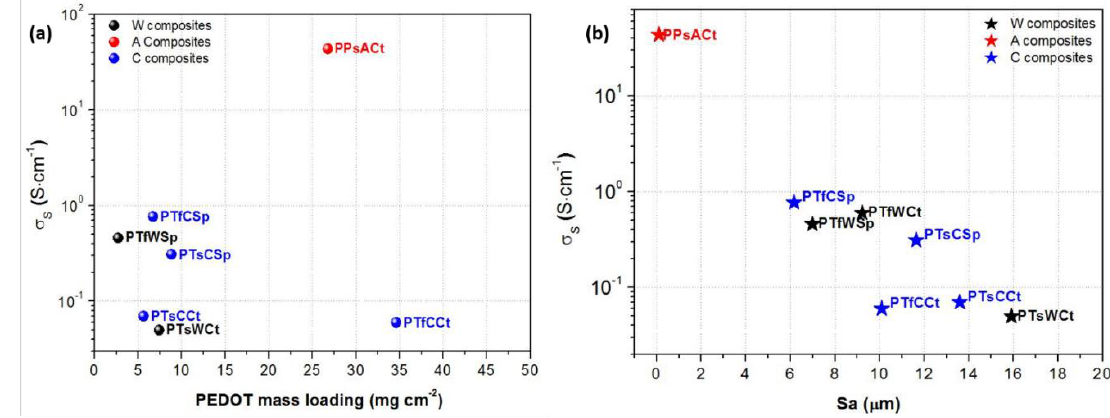
Figure 7. ( a ) σ s dependence on PEDOT mass loading; and ( b ) σ s dependence on Sa roughness for composite materials prepared on different substrates: Whatman ® paper (black); acetate cellulose (red) and cellulose microfibers (blue).